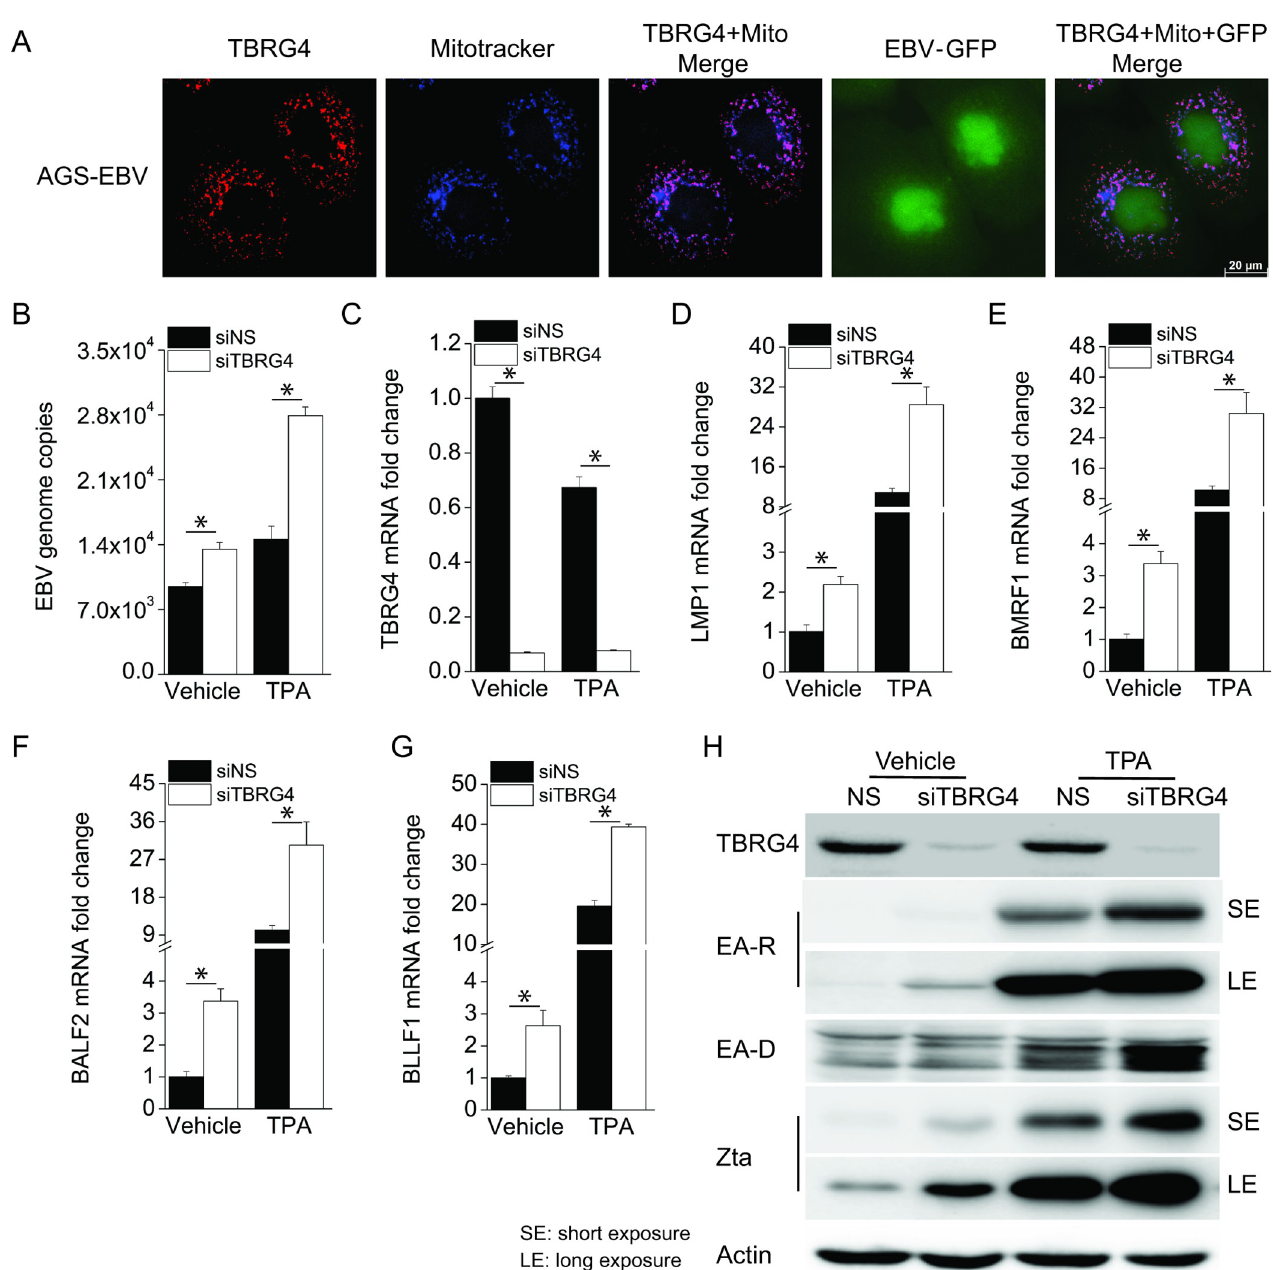
Fig 6. Knockdown of TBRG4 also induces EBV lytic reactivation. (A) AGS-EBV cells were treated with MitoTracker to visualize the mitochondria (blue), then fixed and stained with TBRG4 antibody (red). AGS-EBV cells contain a recombinant EBV constitutively expressing GFP (green). Images were taken using Leica DMi8. (B) AGS-EBV cells were transfected with control NS or TBRG4 siRNA for 48 h and then treated with TPA for 24 h. EBV genome copies were measured by real-time PCR in the supernatant from vehicle- and TPA-treated cells. (C-G) RNA was extracted from the AGS-EBV cells treated as in (B), and the knockdown efficiency of TBRG4 and the mRNA expression of EBV genes LMP1, BMRF1, BALF2, BLLF1 were measured by real-time PCR. (H) Cell lysates were harvested from the AGS-EBV cells treated as in (B), and western blots were performed with the indicated antibodies. The data shown are representative of three independent experiments. Data are presented as mean ± SD. � , P < 0.05 by student’s t-test.